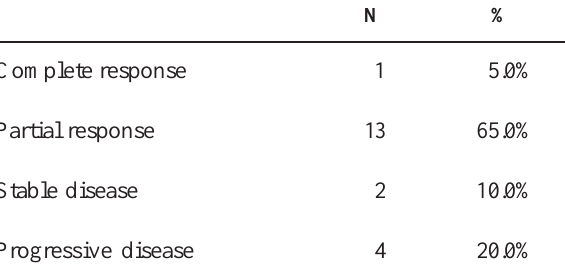
Table 4 – Radiological response rate (n = 20).